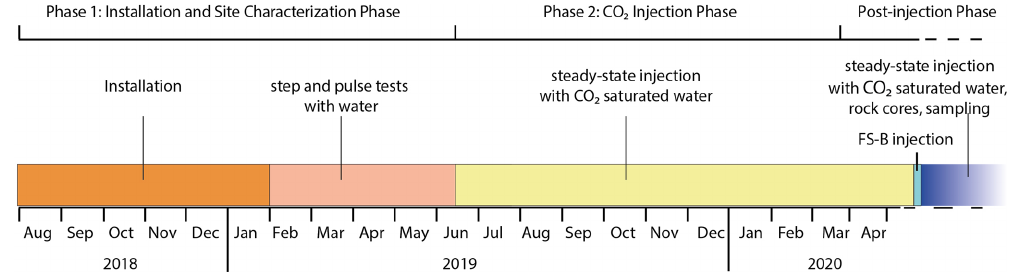
Figure 3. Timeline of CS-D (the FS-B injection has been postponed to a later